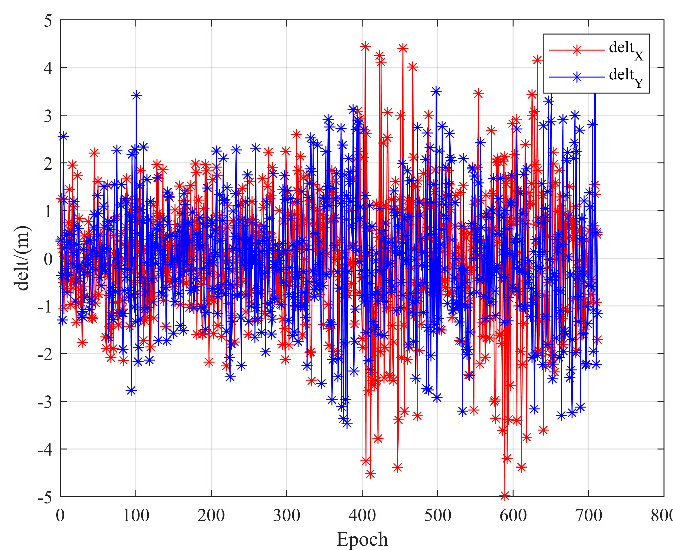
Figure 8. Comparison of the results of the two experiments. In Figure 8, the blue points represent the positioning results obtained when the attitude error is not included, and the red points represent the positioning results obtained after the error is added. From the results, the obvious red points are more divergent than the blue ones; the fact that the edge points are basically red further illustrates this situation; that is, the positioning results with attitude errors are worse. We subtract the results from the two experiments to get Figure 9, where red represents the difference in the X direction, and blue represents the Y direction. Their difference bounces around 0 and ranges between [ − 5, 5].